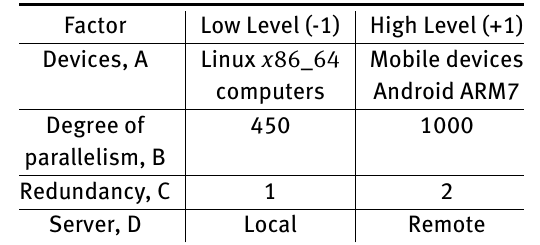
Table 2: Factors and